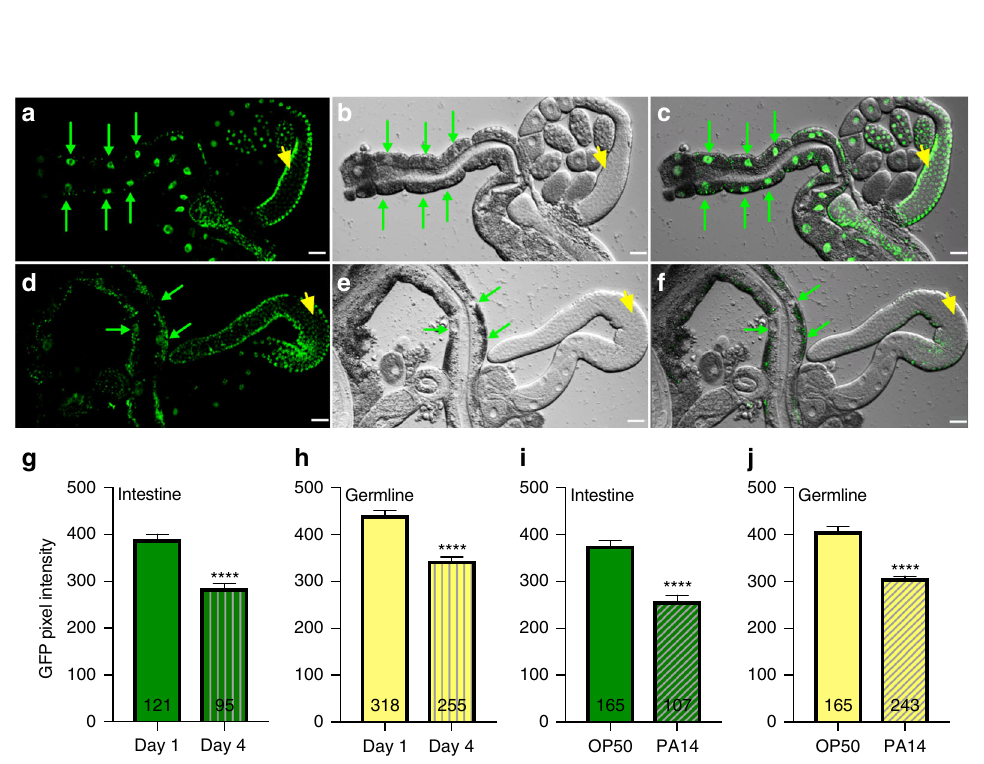
Fig. 4 TCER-1 levels in intestine and germ cells are reduced with age and PA14 exposure. TCER-1::GFP expression in the nuclei of intestinal cells (green arrows) and germ cells (yellow arrowhead) visualized in dissected wild type, day 1 ( a – c ) or day 4 ( d – f ) C. elegans ; the corresponding images, visualized by differential contrast interference (DIC) microscopy, and GFP-DIC overlaps, are shown in ( b , c ) and ( e , f ), respectively. By day 4, expression is signi fi cantly diminished in most intestinal nuclei (compare green arrowheads, quanti fi ed in g ) while a more modest reduction is visible in germ-cell nuclei (quanti fi ed in h ). Note: By day 4, some intestinal nuclei showed no visible GFP and the quanti fi cation does not take these into account. A similar reduction in GFP levels in intestinal nuclei ( i ) as well as germ-cell nuclei ( j ) was exhibited in day 1 adults 12 h after exposure to PA14 (hashed bars in i and j ), as compared to age- matched controls animals on OP50 (solid bars in i and j ). “ n ” signi fi es the total number of nuclei in which GFP intensity was measured from intestines (from 9 to 19 adults per strain per condition) and germlines (from 7 to 13 adults per strain per condition) (see Supplementary Fig. 8 for additional quanti fi cation). Asterisks represent the statistical signi fi cance of the differences in expression in an unpaired, two-tailed t test with P values <0.0001 (****). Error bars represent standard error of the